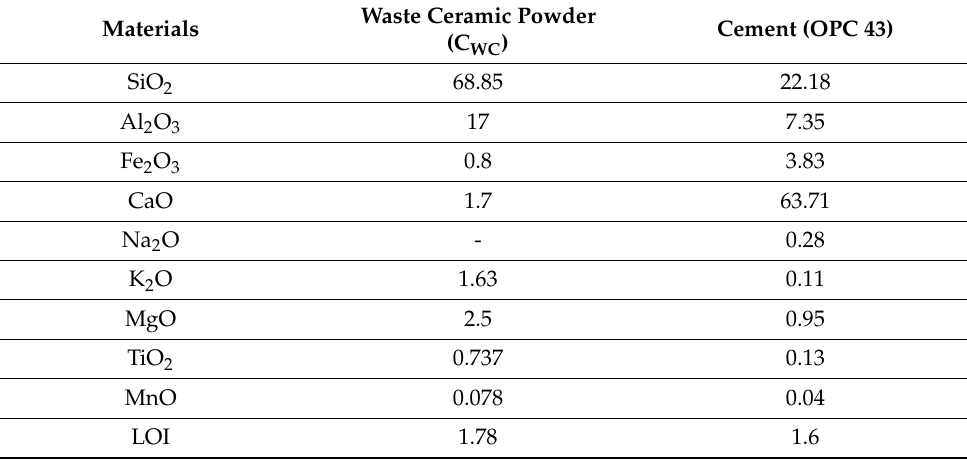
Table 2. Chemical analyses of waste ceramic powder and OPC.